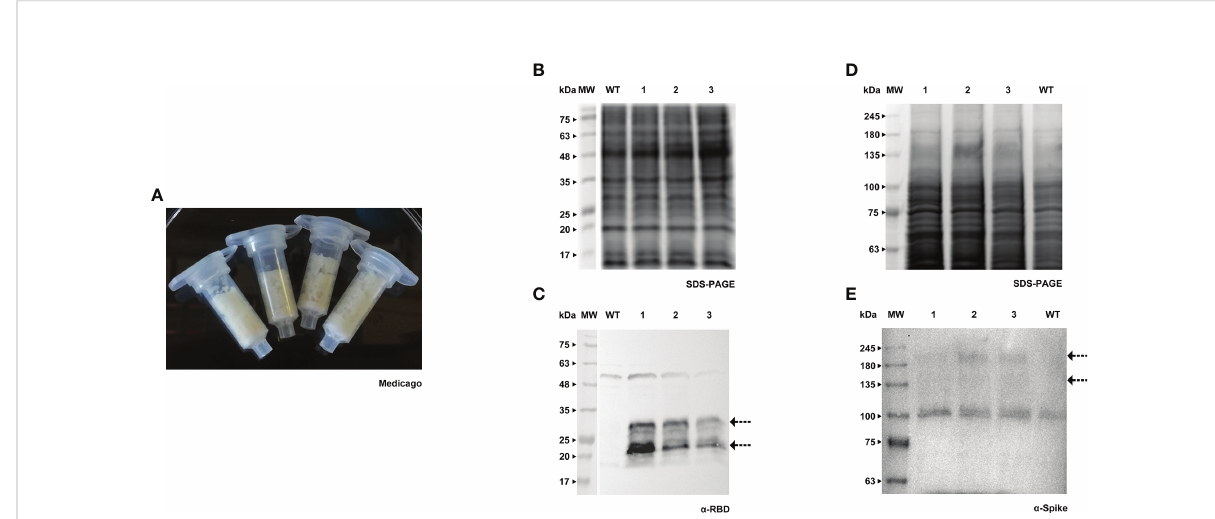
FIGURE 2 Transient expression of RBD and Spike in Medicago cell packs. (A) Receiver columns with Medicago A17 cells. (B) Stained gel containing total protein extract of three independent Medicago cell lines in fi ltrated with pTRA-RBD, WT - wild type. (C) Corresponding WB with anti-RBD antibody. (D) Stained gel containing total protein extract of three independent Medicago cell lines in fi ltrated with pTRA-Spike, WT - wild type. (E) Corresponding WB with anti-Spike